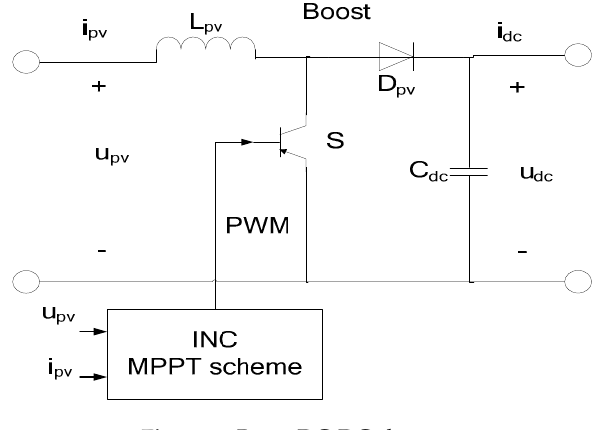
Figure 2. Boost DC-DC chopper.